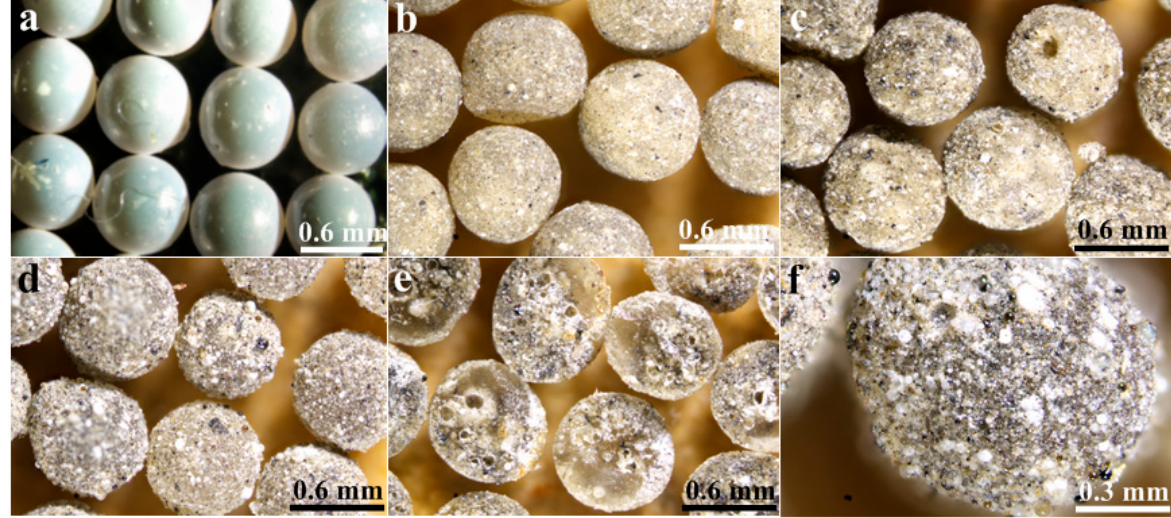
Figure 4. Microscope images of ( a ) pure poly(St- co -MMA), ( b ) 10 wt.% FA, ( c ) 30 wt.% FA, and ( d ) 50 wt.% FA microspheres. ( e ) Cross-section and ( f ) enlargement of 30 wt.% FA